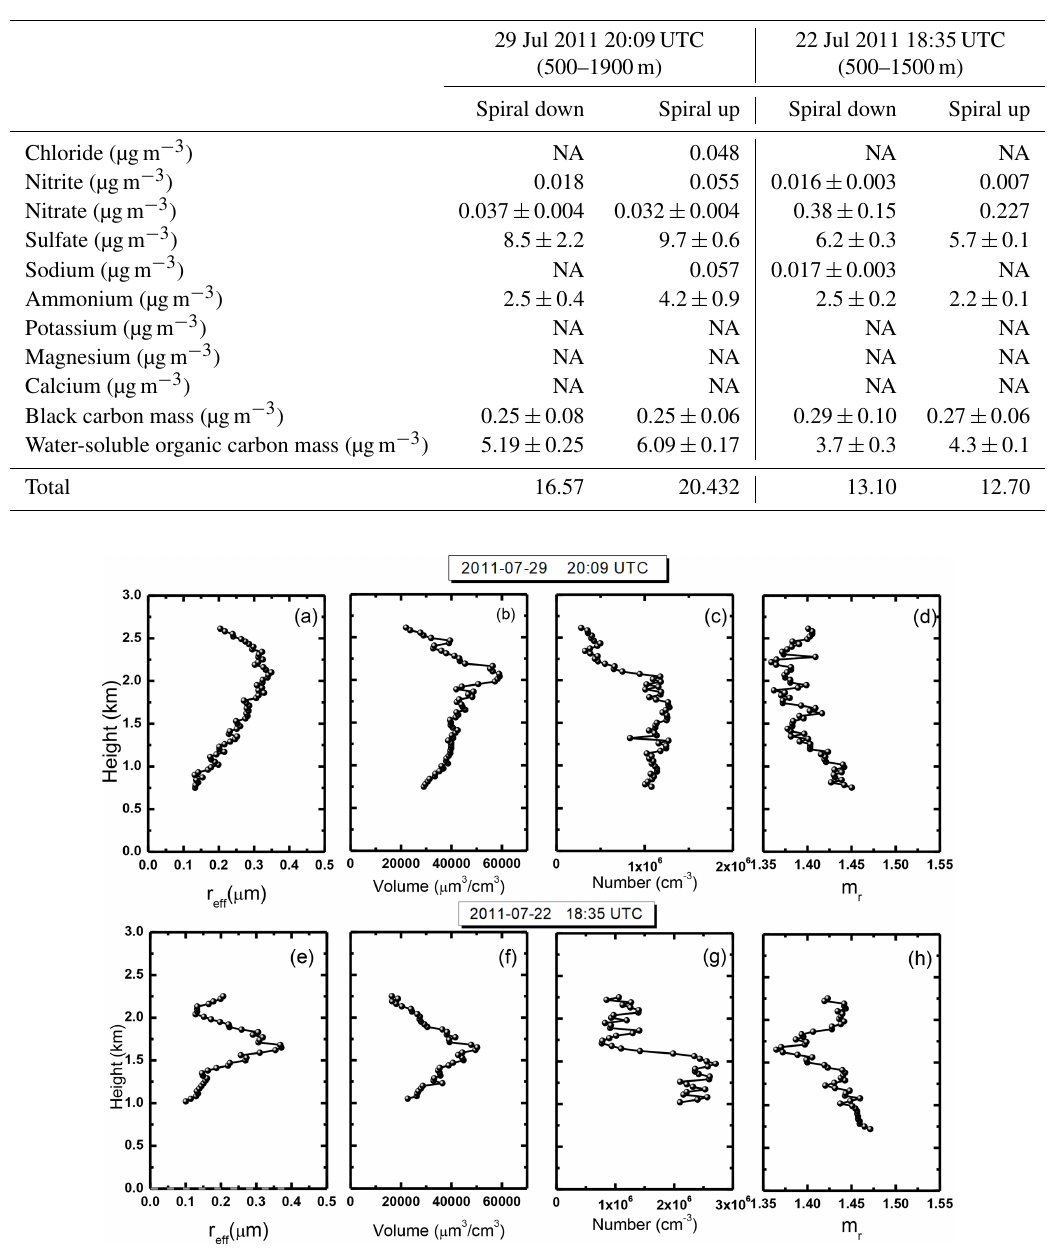
Table 4. Mean values of total mass of the different species that form aerosol particles in the planetary boundary layers.